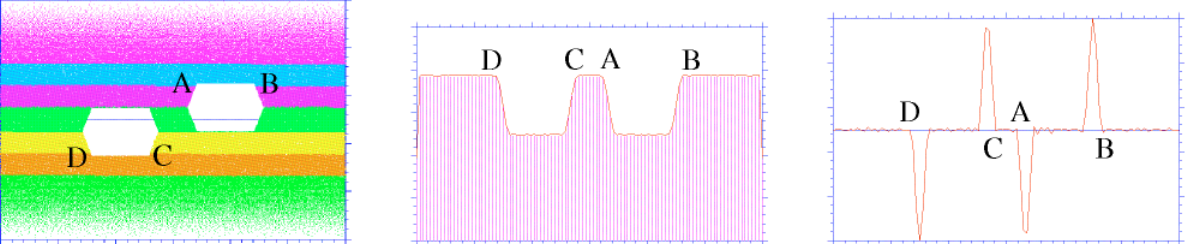
FIG. 16. (Color) Phase space, line density, and space-charge voltage for two